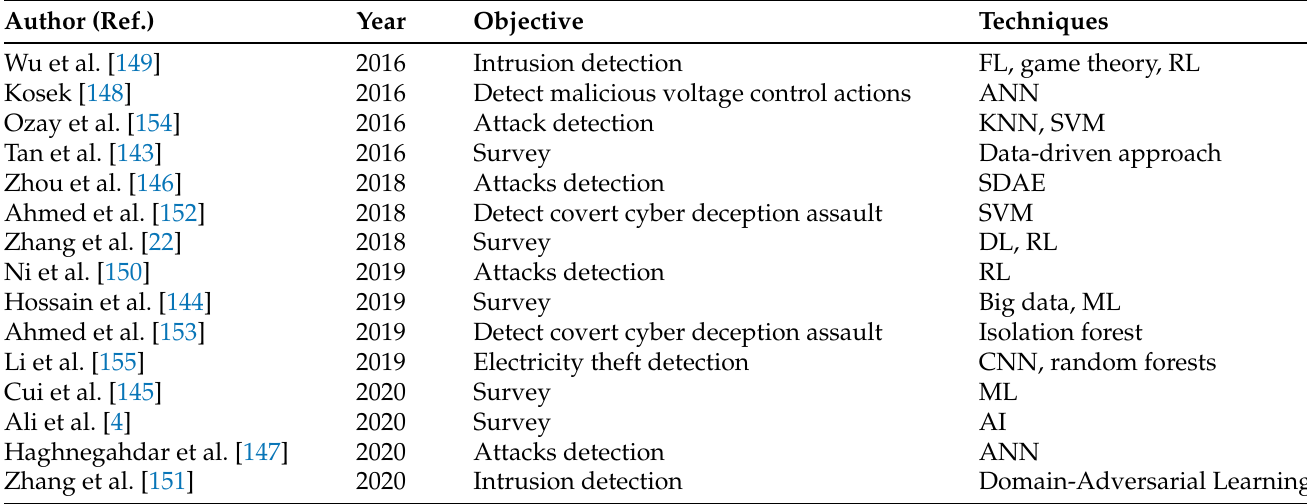
Table 4. Summary of approaches for smart grid